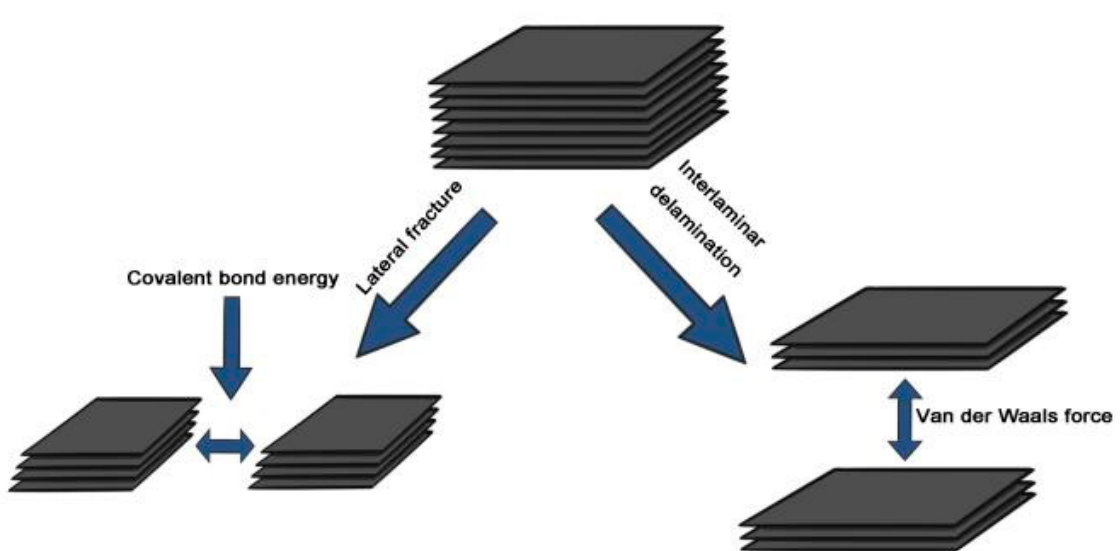
Figure 2. Structure change of graphite during wet ball milling. The powder after wet ball milling is dried in a vacuum drying oven (DZF-6050, Ke- beter, Beijing, China). The initial materials before ball milling and the surface morphology of the composites after ball milling were observed by high resolution scanning electron microscope (SEM, Zeiss-IGMA HD, Jena, Germany) at 5 kV voltage. The dispersion of graphene-wrapped SiC core-shell nanoparticles and the number of graphene layers at different rotational speeds were observed by high resolution transmission electron micro- scope (HRTEM, JM-2100, NEC, Tokyo, Japan) at 200 kV. For the detection of the